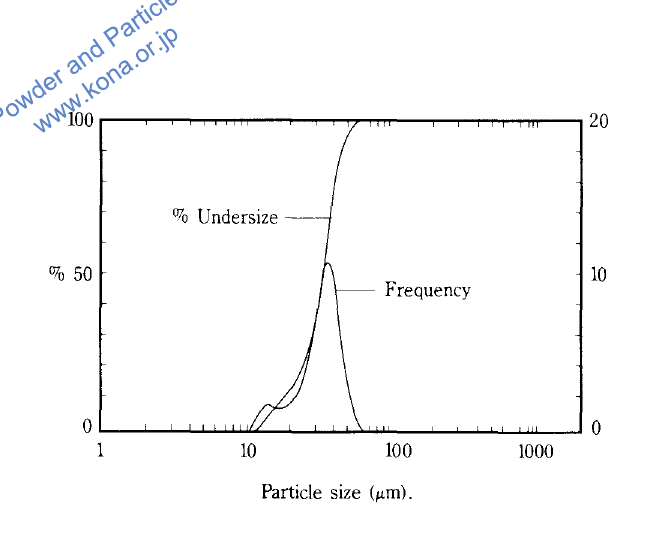
Fig. 5. Particle size distribution for alumina parent bulk material.